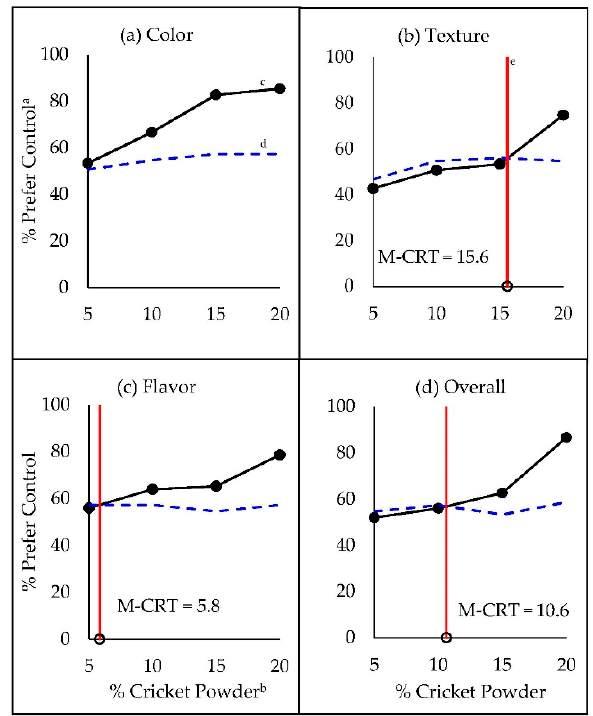
Figure 1. Modified consumer rejection thresholds (M-CRT) for cricket powder in whole-wheat snack crackers. Thresholds were measured based on 2-alternative choice (AC) paired preference tests of ( a ) color, ( b ) texture, ( c ) flavor, and ( d ) overall preference. a Percentage of consumers who reported preference for the control (0% cricket powder) sample. b Percentage of cricket powder used in place of whole-wheat flour ( w / w ) in cracker formulations. c Solid black lines connect points representing % of consumers preferring the control at each level of % cricket powder. d Blue dashed lines connect points representing Thurstonian 2-AC critical values ( α = 0.05) at each level of comparison. e Vertical red lines represent the M-CRT (% cricket powder), estimated at the intersection of lines c and d (not found for color).